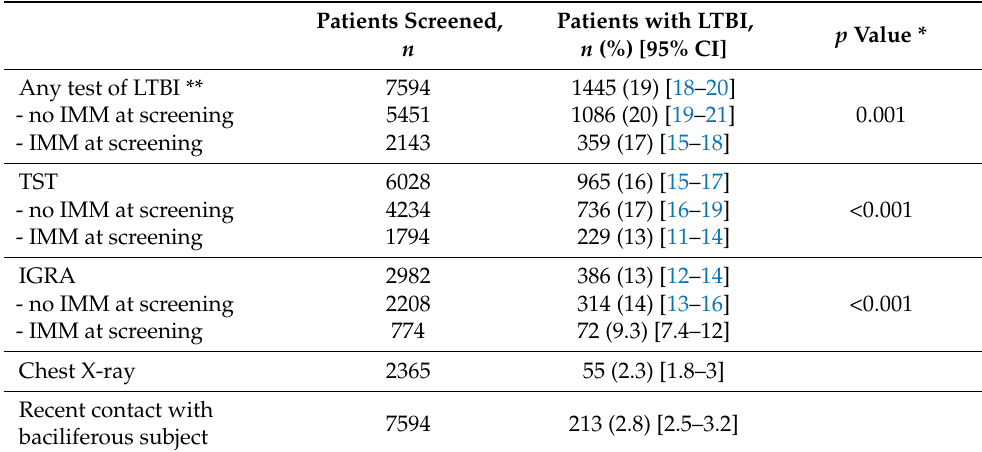
Table 2. Frequency of LTBI and results of the screening